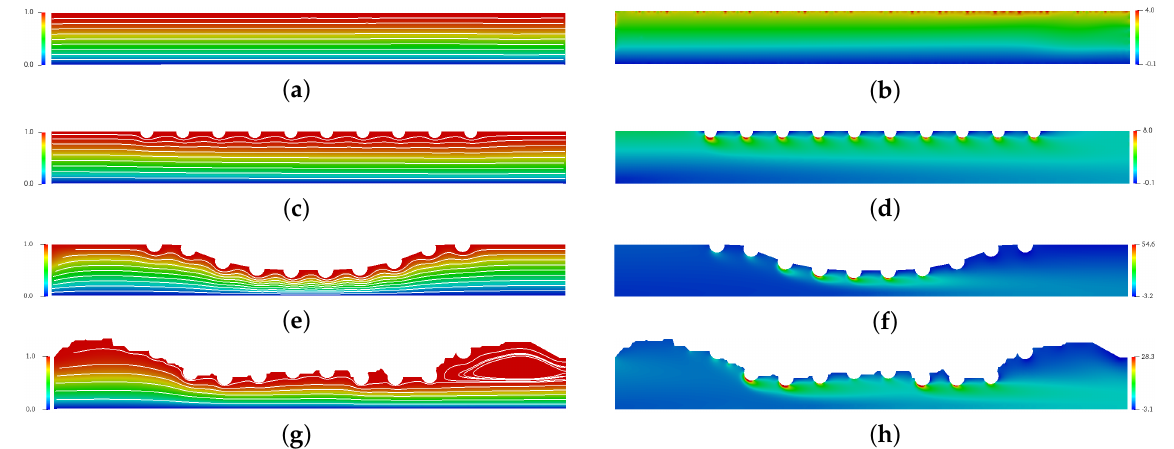
Figure 6. The spatial and temporal distribution of the blood streamlines (left column) and the vorticity field (right column) for the straight channel ( a , b ), the straight channel with drug-eluting stent ( c , d ), the curved channel ( e , f ) and the real channel ( g , h ) with drug-eluting stent for the Reynols number Re = 54.5, where it is calculated using the lumen radius of the coronary artery R = 0.0015 m, the viscosity of the blood µ = 0.0035 N · s/m 2 , the density ρ = 1060 kg/m 3 and the blood flow velocity in coronary artery u = 0.12